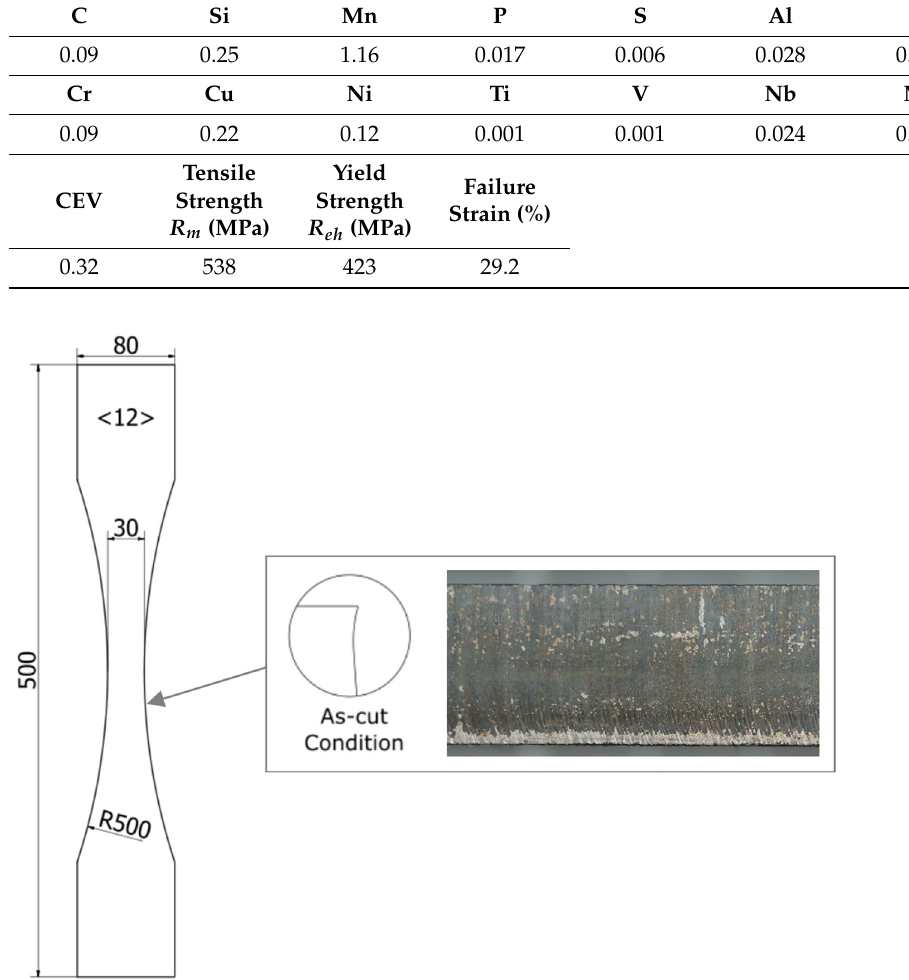
Figure 2. Specimen dimension and cut condition, modified from [12].